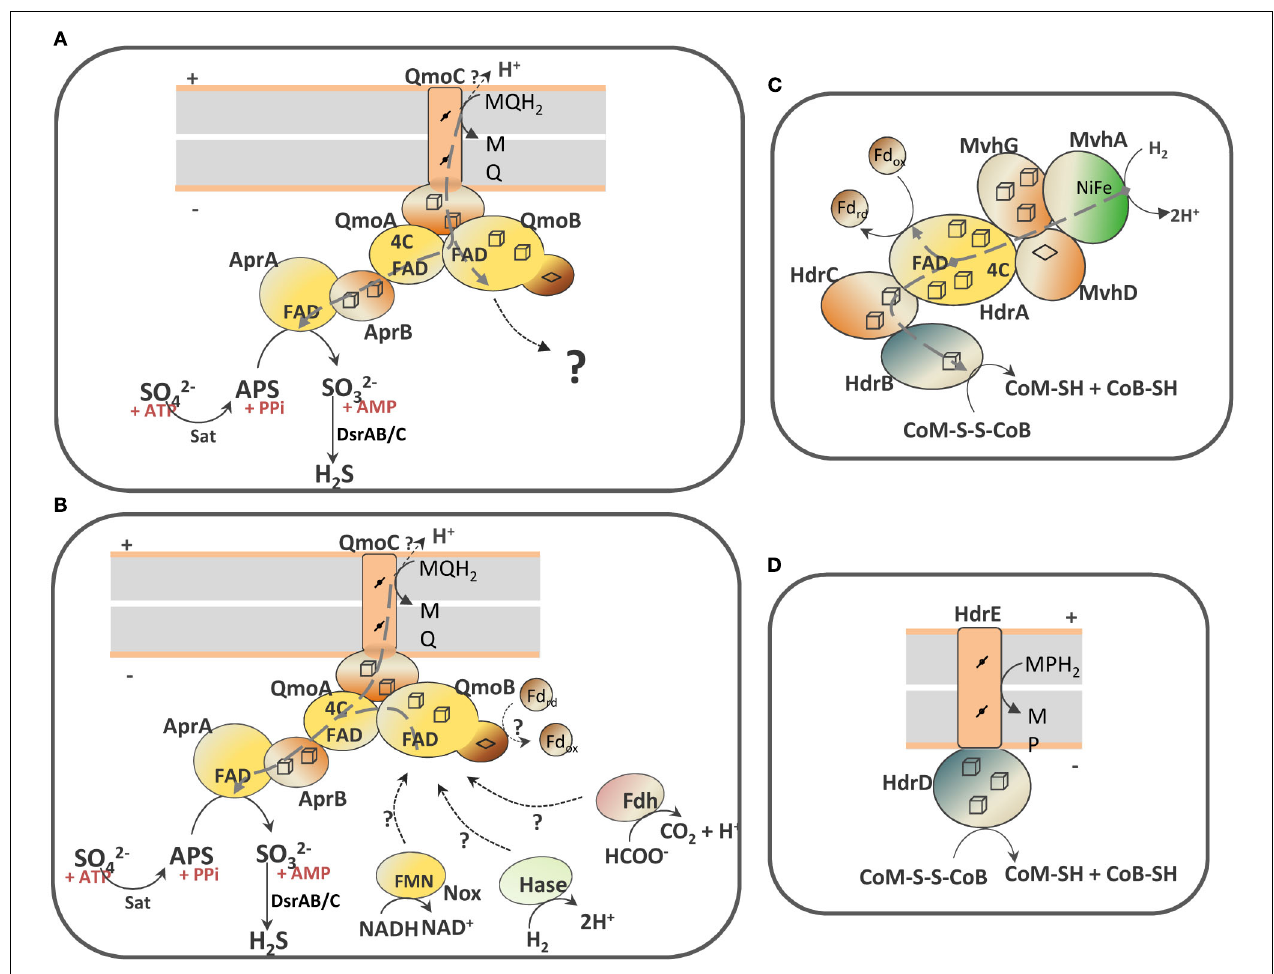
hydrogenase (Hase), formate dehydrogenase (Fdh) or NADH dehydrogenase (Nox).The soluble HdrABC–MvhGAD complex (C) and the membrane-bound HdrED (D) of methanogens are shown for comparison.The gray dashed arrows represent electron bifurcation in (A,C) , or electron confurcation in (B) . The gray boxes represent the cytoplasmic membrane with + indicating the periplasm and − the